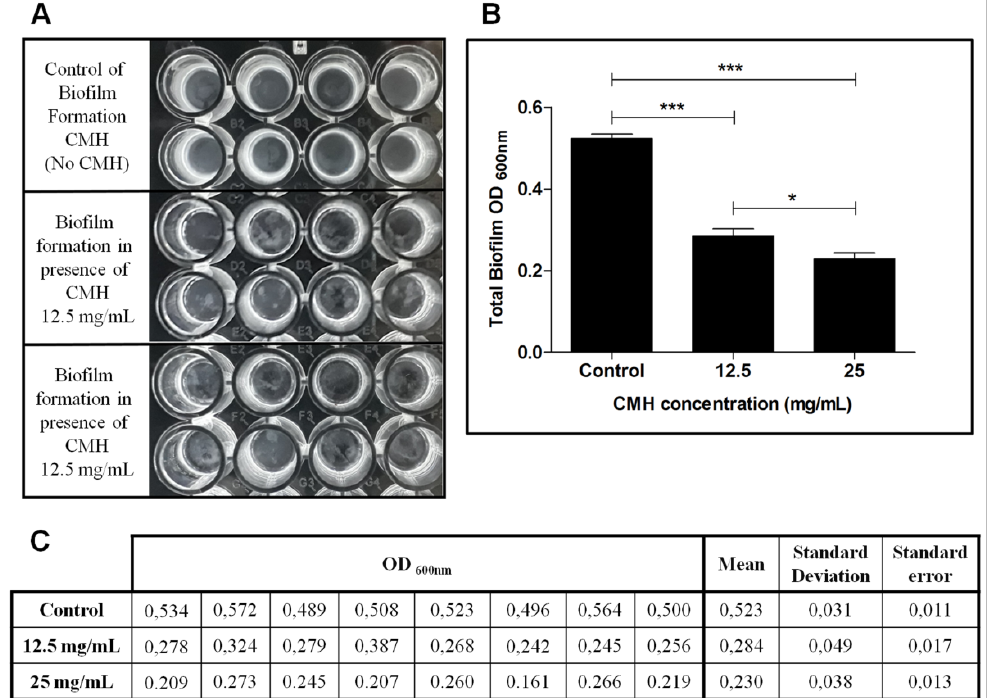
Figure 4. Effect of CMH on MRSA- S. aureus biofilm formation. ( A ) Representative biofilm formation at different concentration of CMH (12.5 and 25 mg/mL) and control. ( B ) Quantification of total biofilm formed in presence or absence of CMH. Absorbance determined at 600 nm. ( C ) CMH effect on MRSA biofilm formation determined by absorbance measurement at 600 nm. Mean, standard deviation and standard error are represented. Statistical differences (* p < 0.05, ** p < 0.001, *** p < 0.0001) are represented by asterisks (ns = not significant).